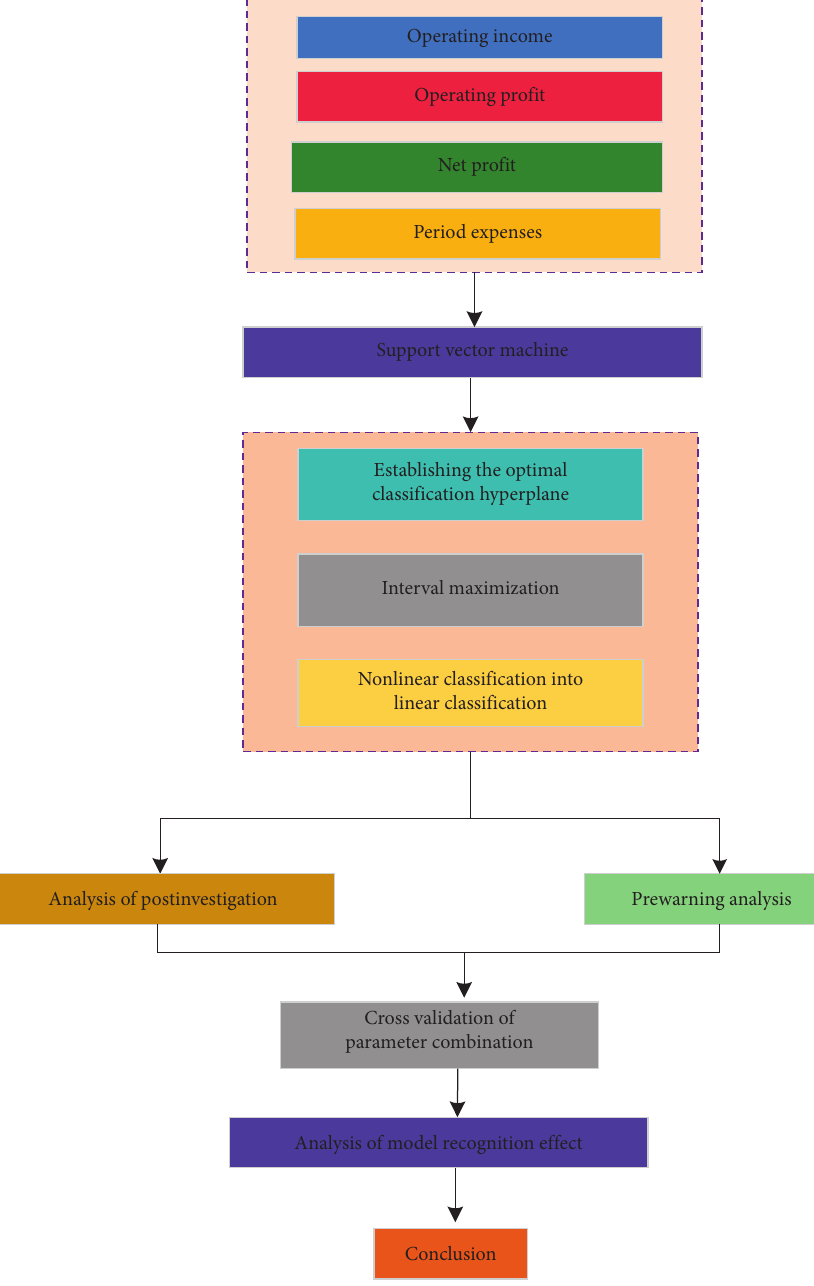
Figure 1: Framework of the overall